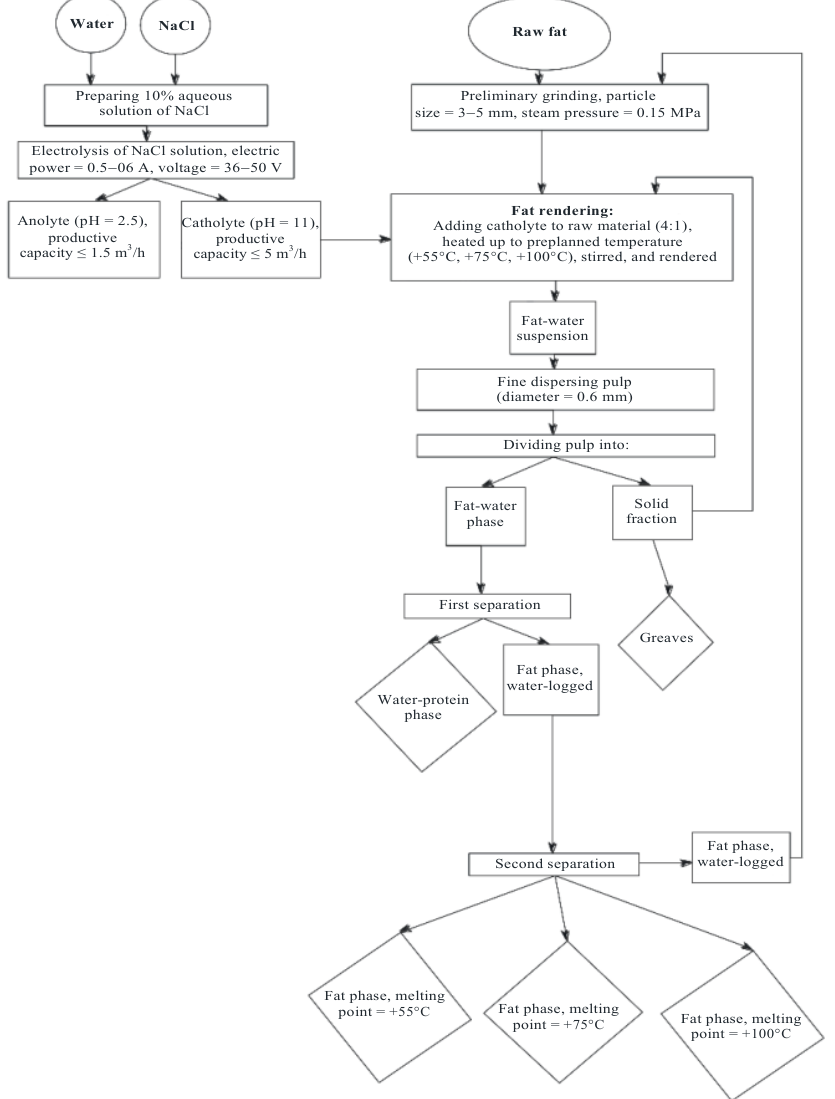
Figure 1 Technological scheme of ostrich fat